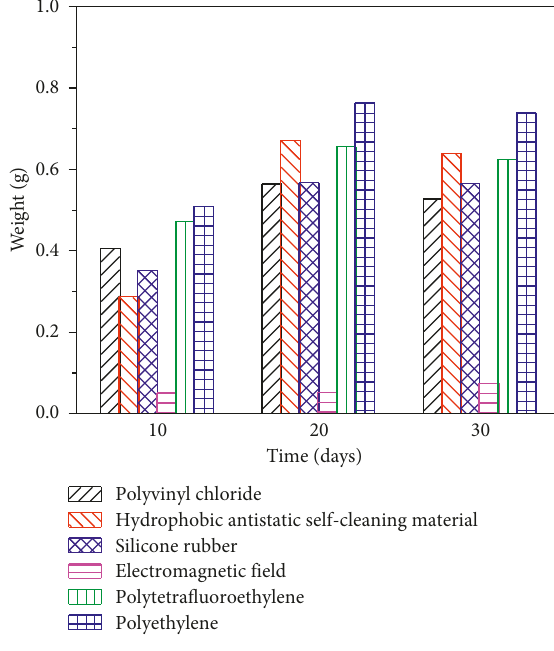
Figure 5: Experimental result. Table 2: Results of the water sample tests.